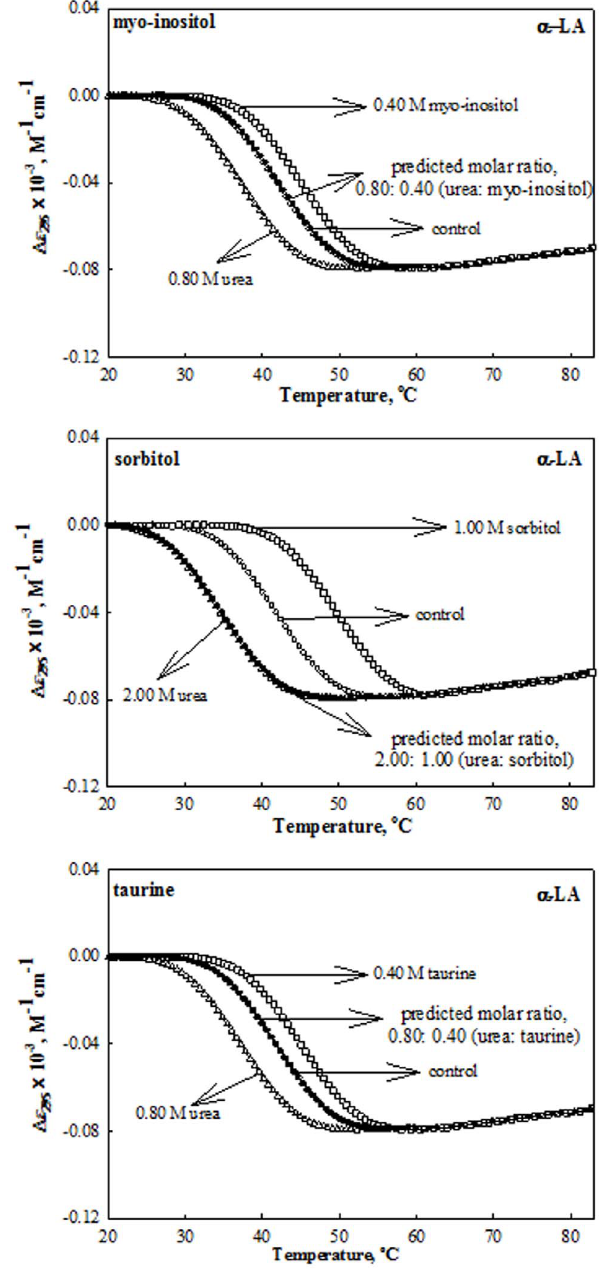
Figure 3. Effect of urea, stabilizing osmolytes and their mixtures (at predicted ratio for perfect counteraction) on a - LA at pH 7.0 and 25 6 C. Representative thermal denaturation curves of a -LA in the presence of the indicated concentrations of urea, osmolytes and their mixtures at predicted ratios given in Table 2. To maintain clarity all data points and all transition curves are not shown. D H D C m and p (constant-pressure heat capacity change on denaturation) in the Gibbs-Helmholtz equation, CD Measurements The far- and near-UV circular dichroism (CD) spectra of RNase A, lysozyme, and a -LA in the presence and absence of the co-